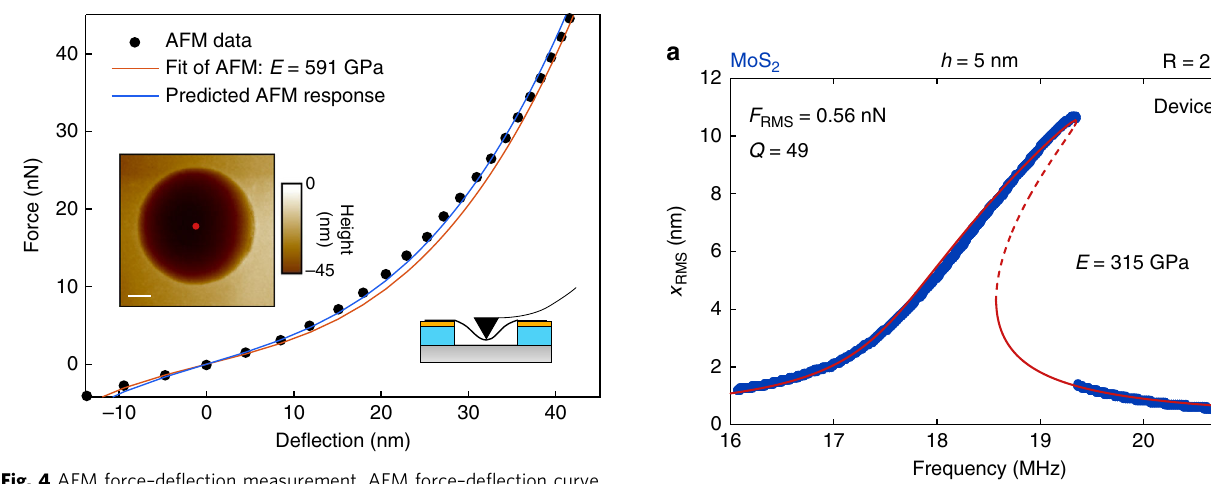
Fig. 4 AFM force – de fl ection measurement. AFM force – de fl ection curve during tip retraction and the corresponding fi t (red curve). Inset shows the AFM image of the drum (scale bar is 1 μ m). The curve is taken at the center of the drum for device 1 (marked by the red dot in inset). The blue curve represents the predicted AFM response using the n 0 = 0.107 N m − 1 and E = 594 GPa, obtained from the fi t of the nonlinear dynamic